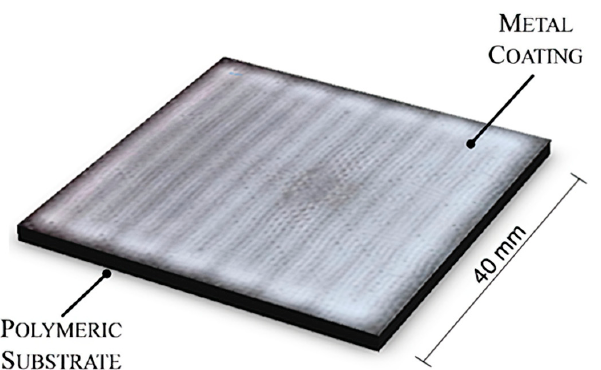
Figure 3. Real picture of carbon-fiber-reinforced polymer-substrate coated with a single pass of aluminum particles.